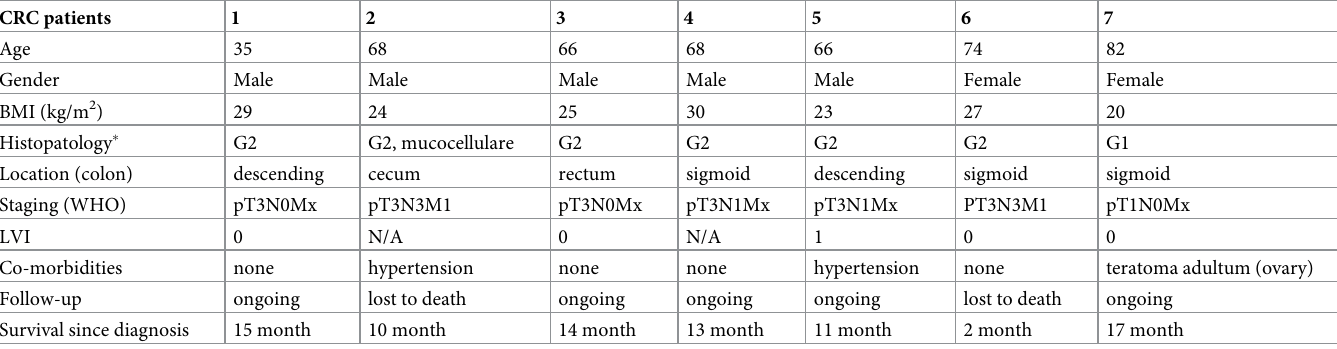
Table 1. Demographic data for patients diagnosed with colorectal cancer.